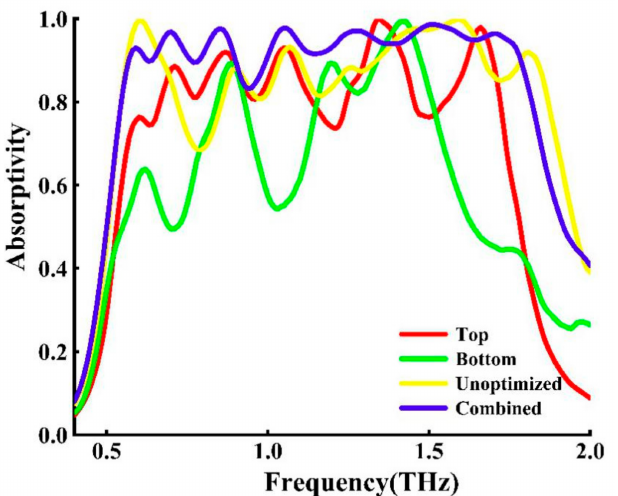
Figure 3. The unoptimized structure and the optimized absorption spectra of the top, bottom and combined layers after optimization. The yellow curve shows the broadband response before the structure is optimized, the red curve shows the broadband response of only the top layer, and the green curve shows the broadband response of only the bottom layer. Using the two-layer structure at the same time, a combined broadband response is obtained, as shown in the purple